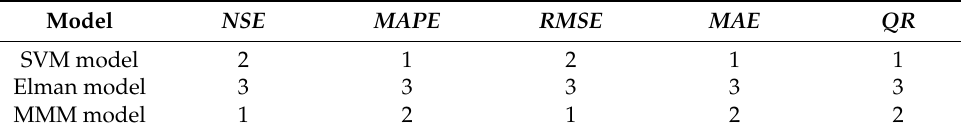
Table 3. The ranking of the three models under five indicators ( r i ).